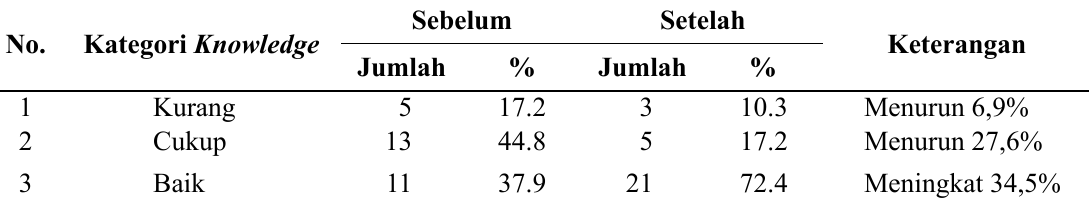
Tabel 7. Perbandingan kinerja pendokumentasian askep sebelum dan setelah pelaksanaan intervensi